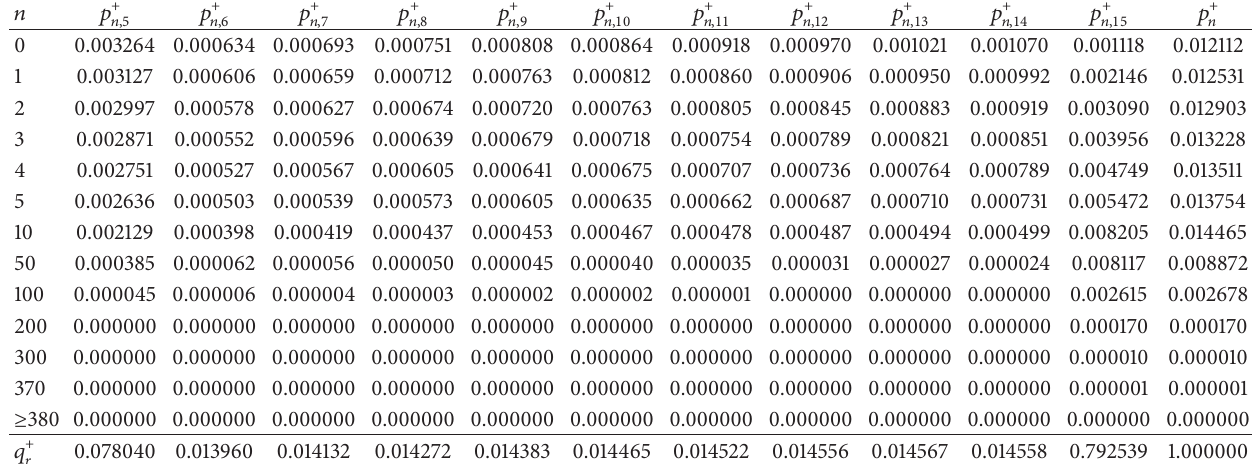
Table 1: Joint distribution of queue and server content at departure epoch ( 𝑝 + 𝑛,𝑟 ) of an 𝑀/𝐺 (5,15) 𝑛 /1 queue with 𝐺 ∼ 𝑀 , 𝜆 = 252 , 𝜇 𝑎 = 11 , = 𝜇 + 1 , and 𝜌 = 0.8 𝜇 𝑟 𝑟−1